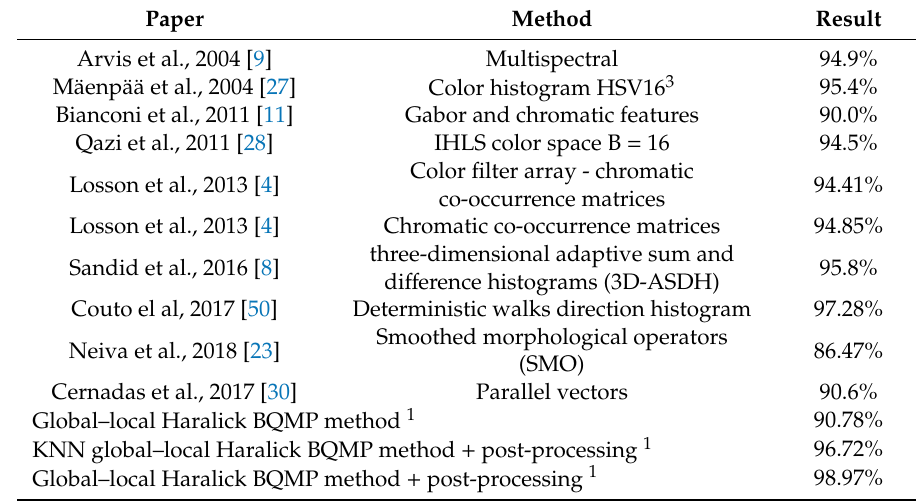
Table 6. Best results of global–local Haralick–BQMP classification for the Outex database with 68 images. The best previously published results are compared to our